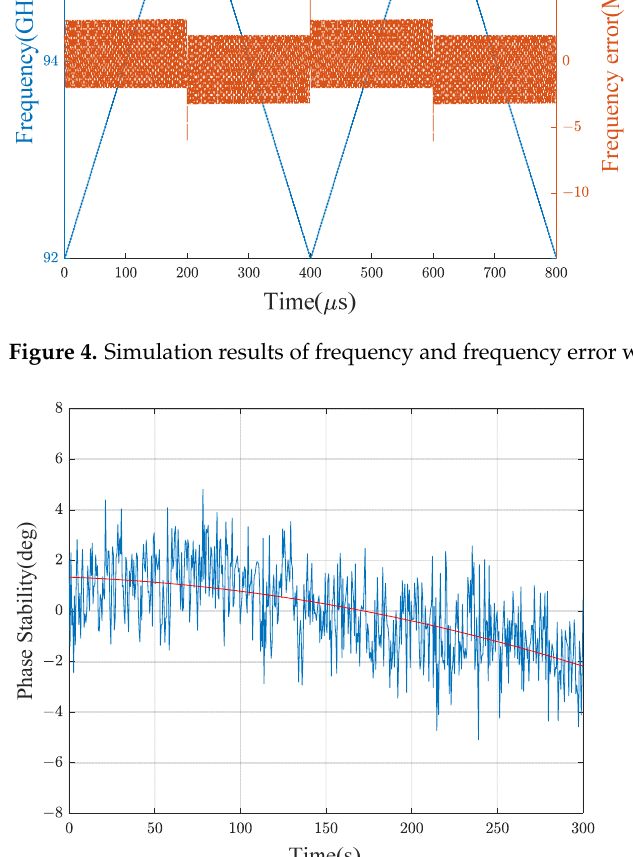
Figure 5. Test results of phase stability between pulses with time.